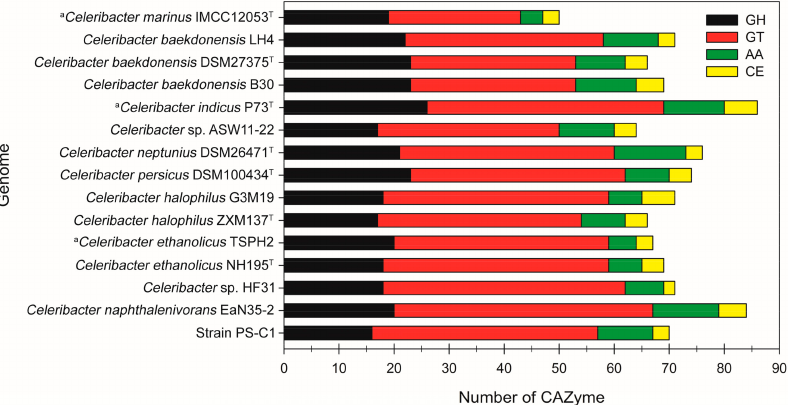
Figure 3. Total number of CAZymes present in strain PS-C1 and 14 other known genomes of Celeribacter spp. GH: glycoside hydrolase; GT: glycoside transferase; AA: auxiliary activity; CE: carbohydrate esterase; a complete genome; T type